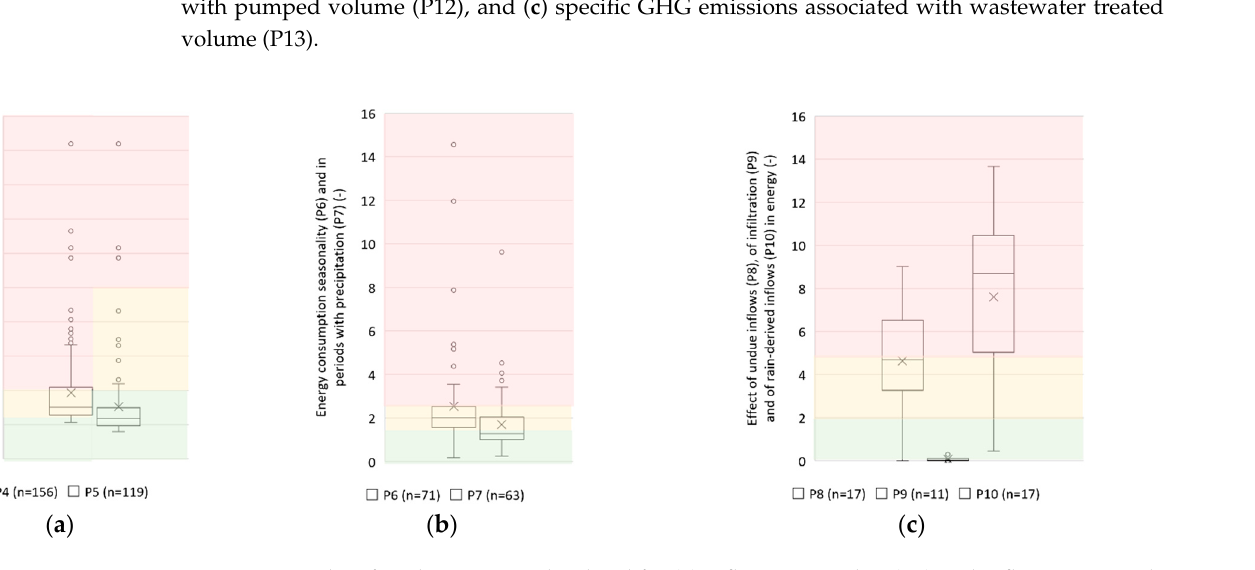
Figure 7. Results of evaluation at utility level for ( a ) inflow seasonality (P4) and inflows in periods with precipitation (P5), ( b ) energy consumption seasonality (P6) in periods with precipitation (P7), and ( c ) effect of undue inflows (P8), of infiltration (P9), and of rain ‐ derived inflows (P10) in energy.